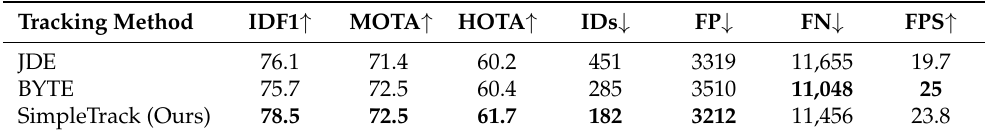
Table 6. Comparison of different association methods on the MOT17 validation set. JDE expresses the tracking strategy employed by [11–13,17] and BYTE expresses the tracking strategy employed by [10]. The best results are shown in bold